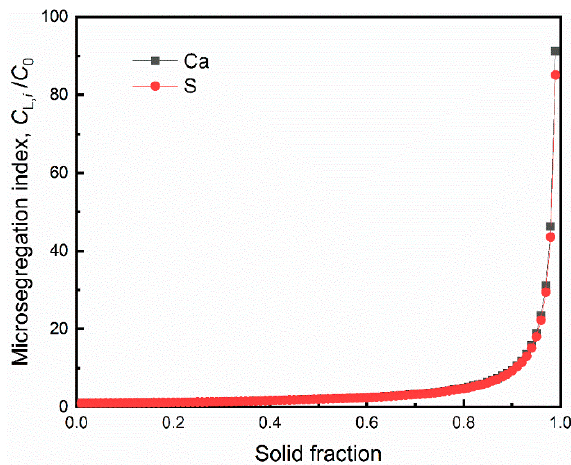
Figure 11. The interdendrite solute segregation during solidification. The ratio of interdendritic solute concentration to initial solute concentration was defined as the microsegregation degree ( C L,i / C 0 ).